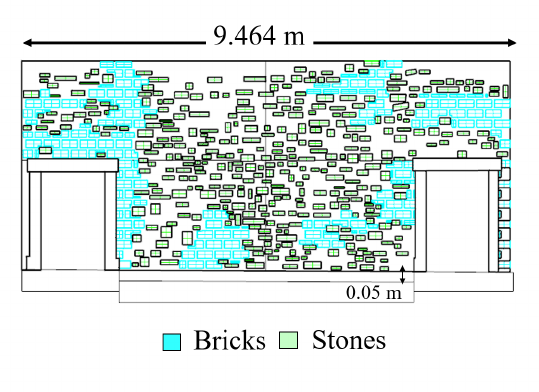
Figure 5. Front view of three-dimensional model showing existing locations of stone, brick, and mortar, overall geometry, and settlement conditions.